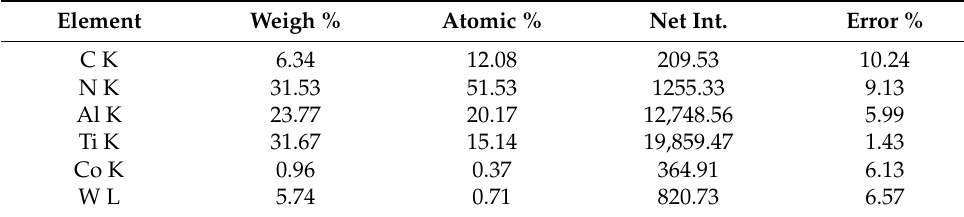
Table 2. The composition of the TiAlN